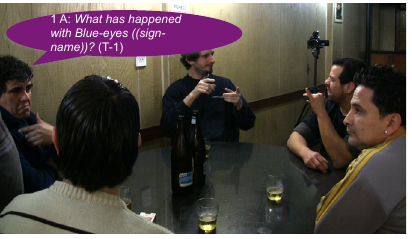
Figure 10. ‘Huh?’ , Person B (right) initiates repair on Person A’s previous turn by puffing his cheeks out and simultane- ously bringing his eyebrows together and lifting his head up (line